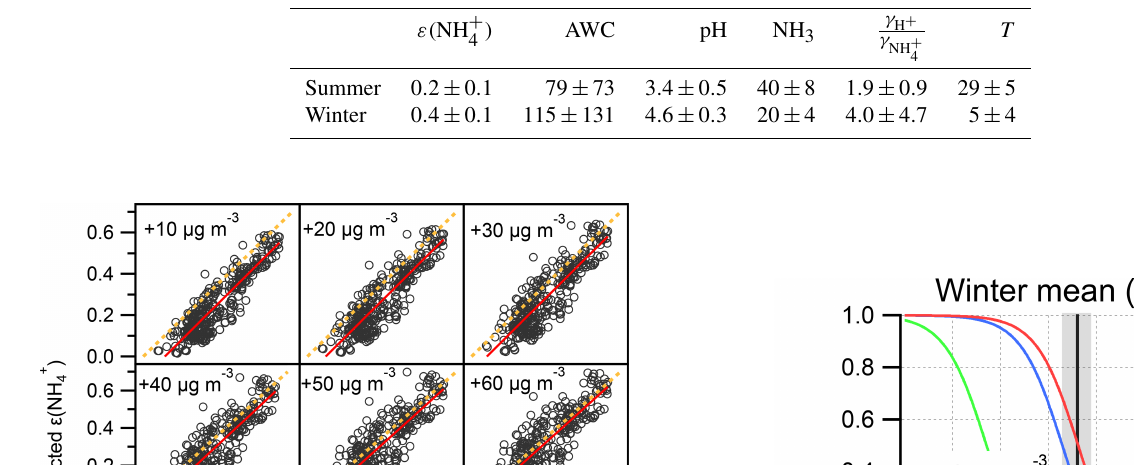
), pH, T , activity coefficients ratio of 4